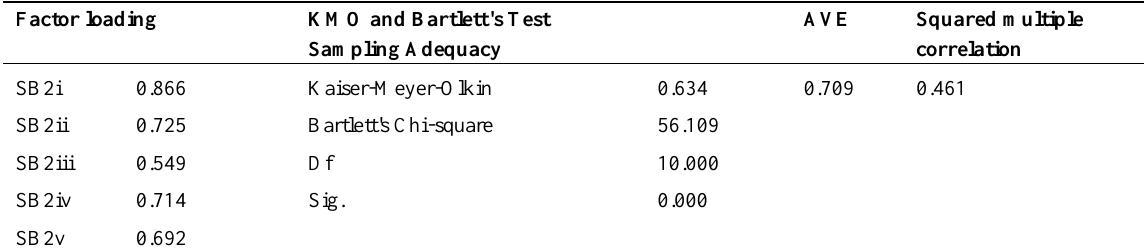
Table 1: Kaiser-Meyer-Olkin (KMO) and Bartlett’s statistics